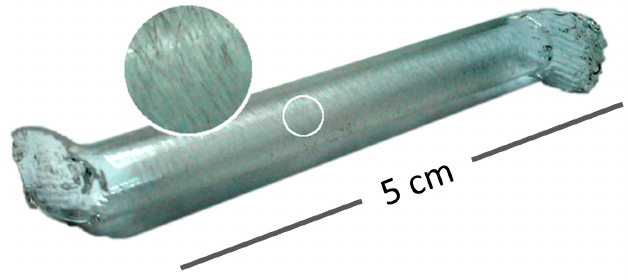
Figure 1. Capsule with molded hooked ends and sanded surface.